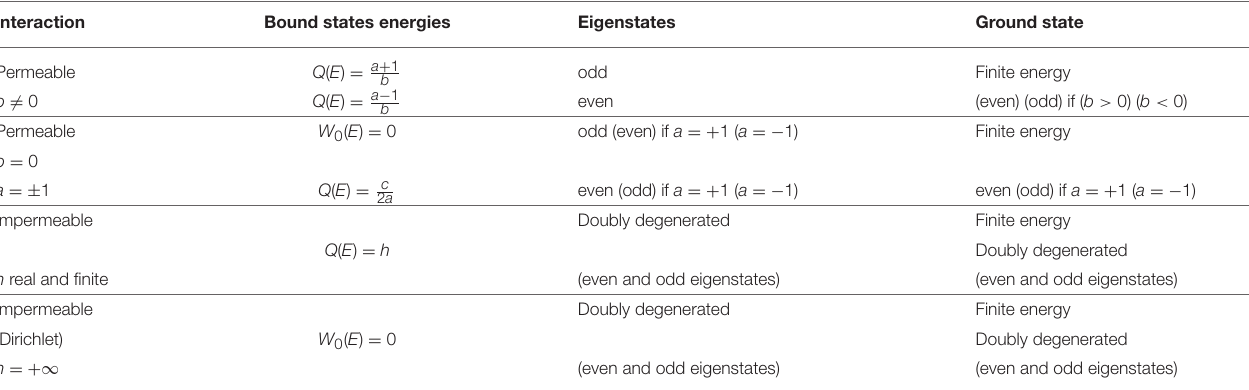
TABLE 1 | Bound state energies and properties under parity of the corresponding eigenstates, for all subfamilies of parity invariant (even) attractive Coulomb interactions. Interaction Bound states energies Eigenstates Permeable